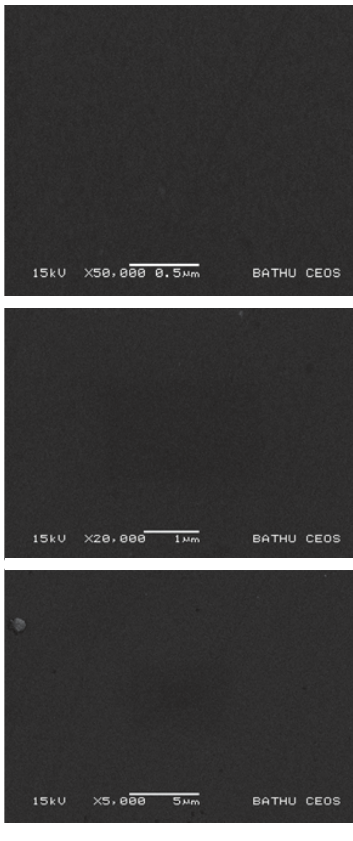
Figure 2: SEM image of PbTe thin